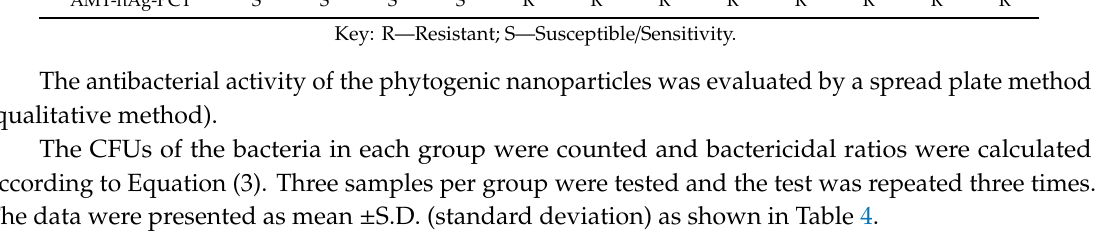
Table 3. Antimicrobial susceptibility of the microorganisms to AgNPs. Concentration of AgNPs, ( µ g / mL).